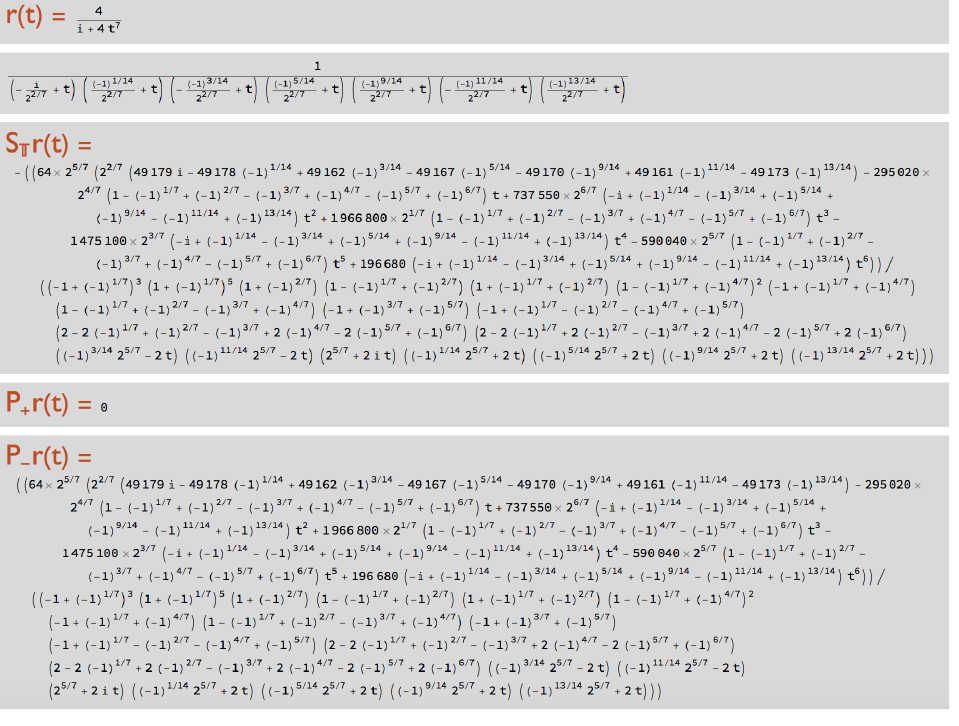
Figure 52. Output given by the [ASPPlusPMinus]